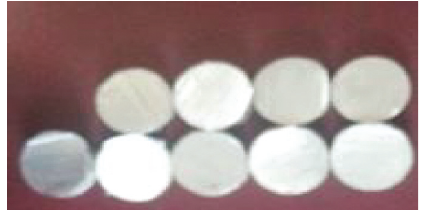
Figure 1: Photograph of composite specimen for WEDM. Table 1: Parameters and its levels.